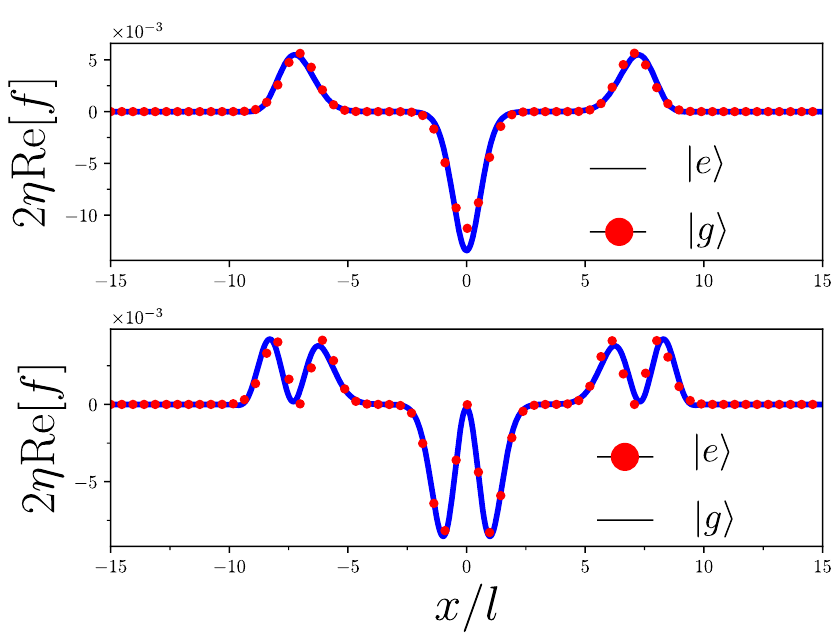
Figure 5: Comparison between the numerical solution of Eqs. (28), (29) (blue line) and the corresponding linear approximation (red dots) for an impurity initialized either in the ground state | g 〉 (top) or the first excited state | e 〉 (bottom) of a harmonic oscillator. Plotted are the densities of the Bose gas at t ≈ 7.1 calculations are implemented with N = 1500, g = 1.0 of the Bose gas at t = 0 is ρ = 50 / l